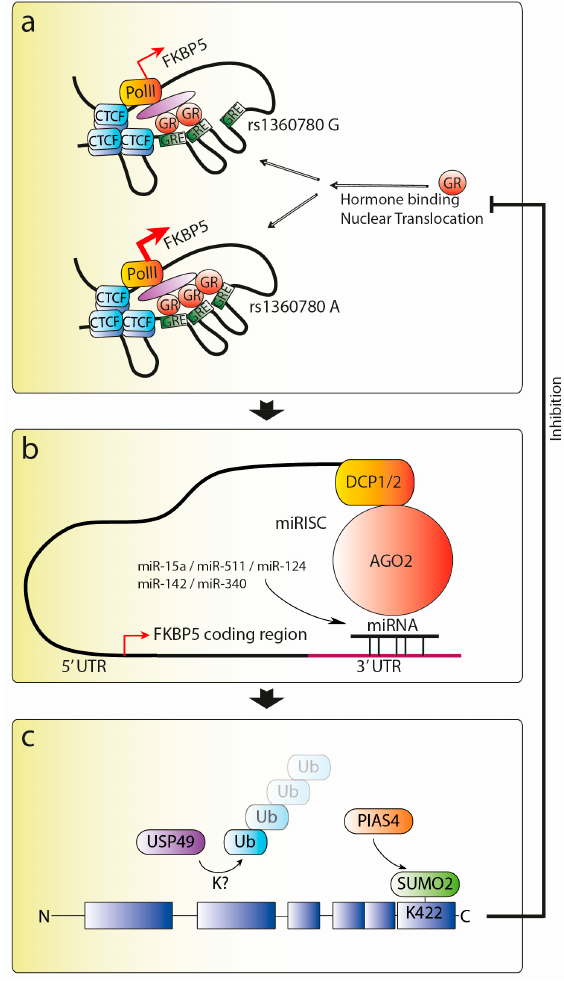
Figure 3. Model of FKBP51’s regulation at different levels. ( a ) Transcriptionally, FKBP5 is modulated by several single nucleotide polymorphisms, including the functional rs1360780 located within intron 2 and chromatin organizing proteins such as the CCCTC-binding factor. The scheme in Panel A is a hypothetical combination of two chromatin architecture studies [105,106]; ( b ) post-transcriptionally, microRNAs can interfere with the stability and translation of the FKBP5 mRNA molecules; ( c ) post-translationally, FKBP51 is regulated by post-translational modifications, such as ubiquitination (probably at lysines 352 und 376, www.nextprot.org/entry/NX_Q13451/proteomics) and SUMOylation. FKBP51 not only is engaged in various signaling pathways (see below), but also forms an ultrashort negative feedback loop by inhibiting its own production at the transcriptional level. Abbreviations: AGO2 = argonaute 2 (the catalytic subunit of the RISC complex); GR = glucocorticoid receptor; GRE = glucocorticoid response element; CTCF = CCCTC-binding factor; DCP = decapping protein; miRNA = microRNA; PIAS = protein inhibitor of activated STAT; PolII = RNA polymerase II; RISC = RNA-induced silencing complex; SUMO = small ubiquitin-like modifier USP = ubiquitin-specific peptidase; UTR = untranslated region.